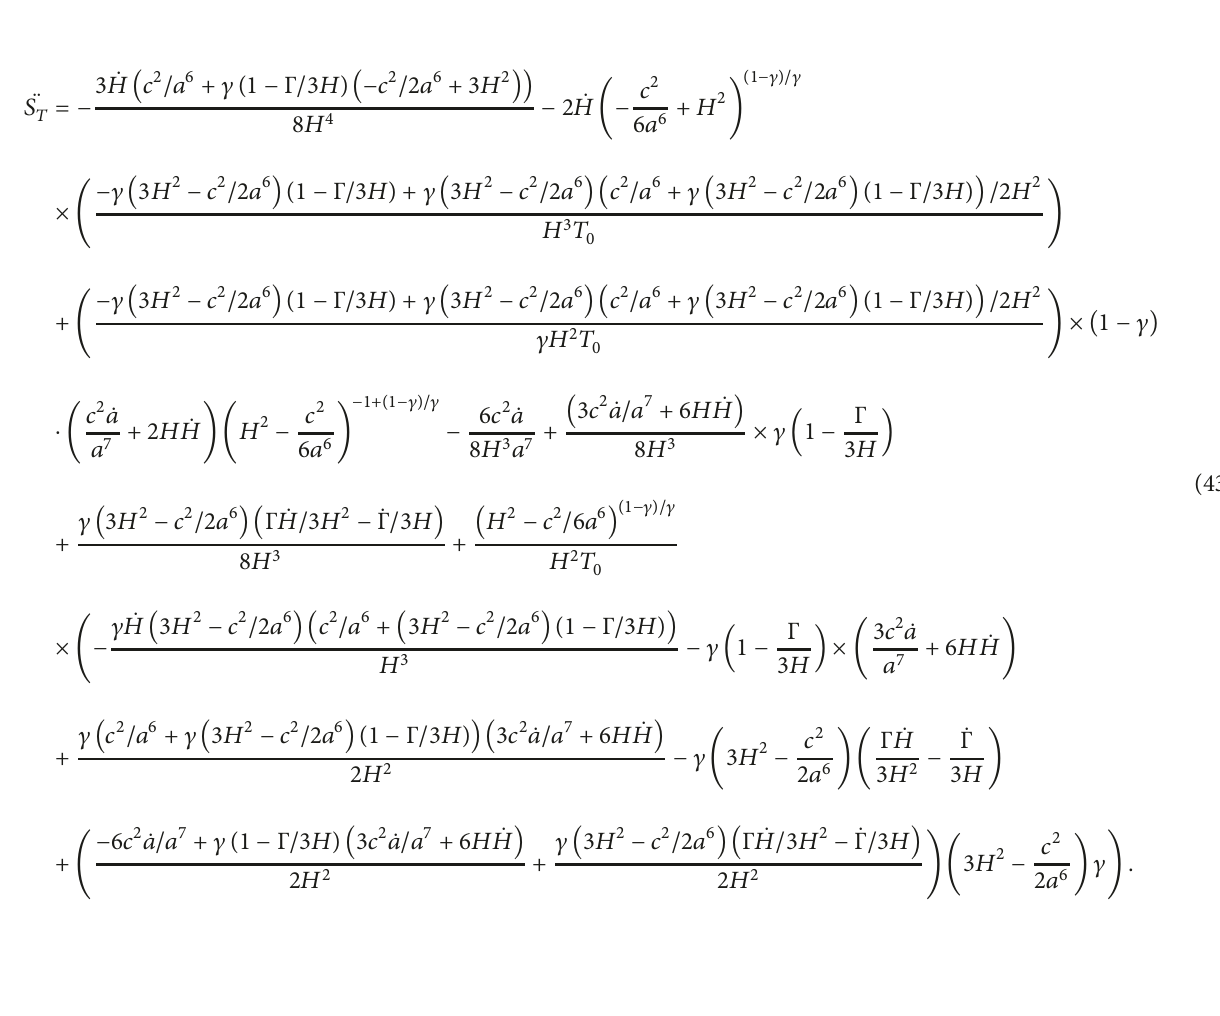
Figure 8: Plot of